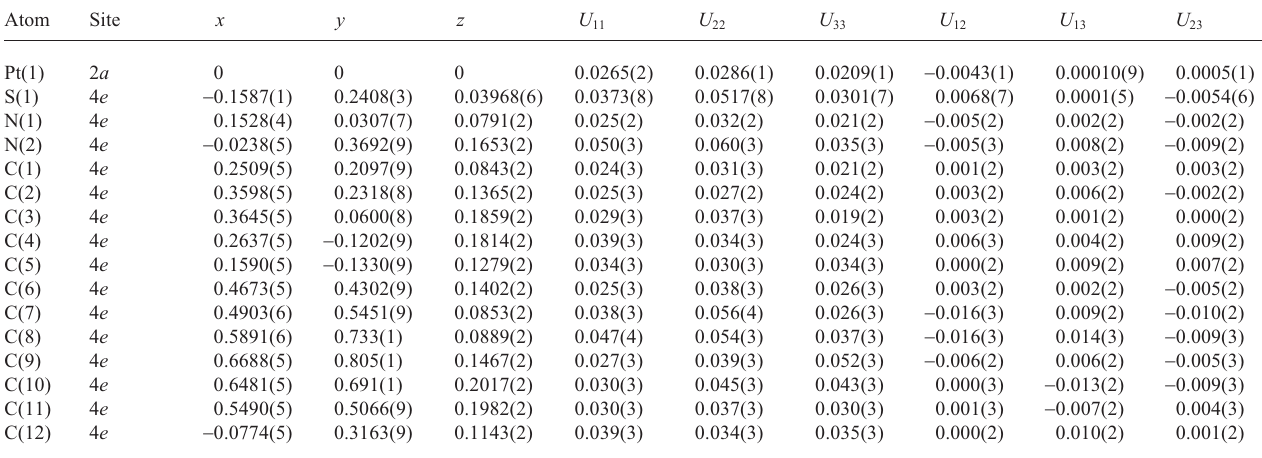
Table 3. Atomic coordinates and displacement parameters (in Å 2 )